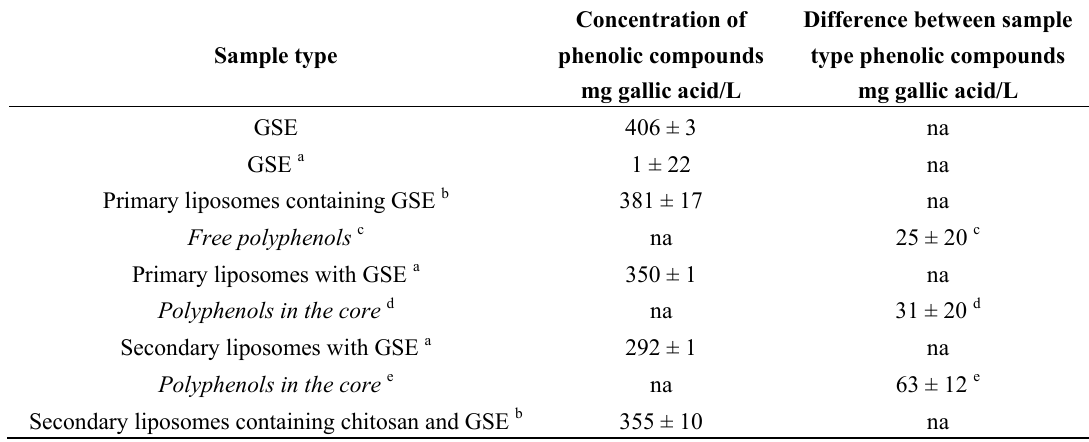
Table 1. Concentration of total polyphenolic compounds (mg gallic acid/L) of GSE alone and incorporated into different liposomal systems measured by the Folin-Ciocalteu